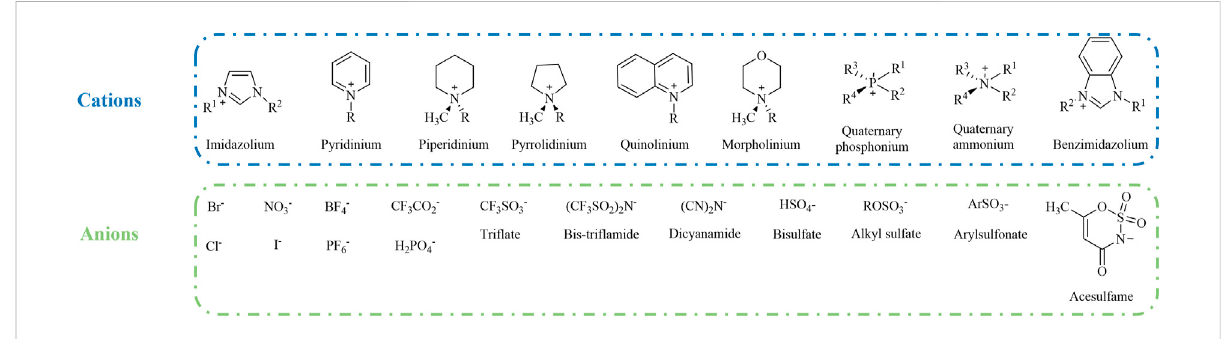
FIGURE 1 Commonly used cations and anions for ionic liquid combination.